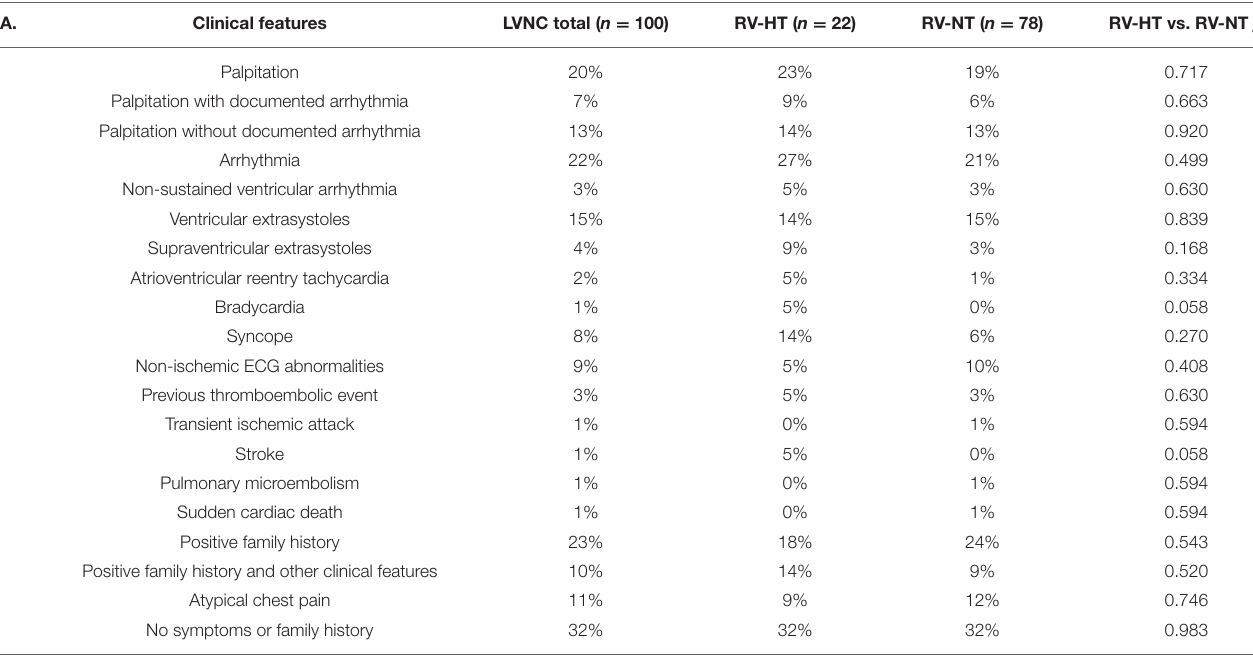
TABLE 4 | Prevalence of clinical features in the total patient population and patient